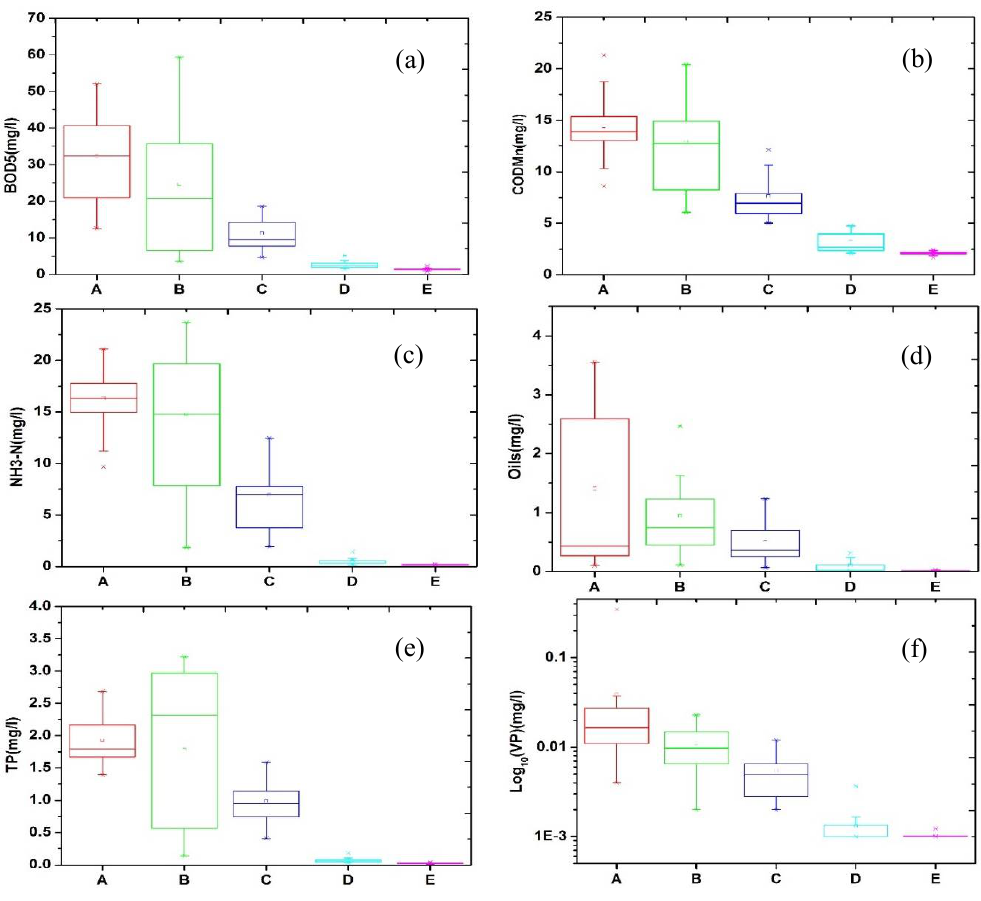
Figure 3. Spatial variations in water quality from 1990 to 2010, ( a ) BOD 5 ; ( b ) COD Mn ; ( c ) NH 3 -N; ( d ) Oils; ( e ) TP; ( f ) VP.